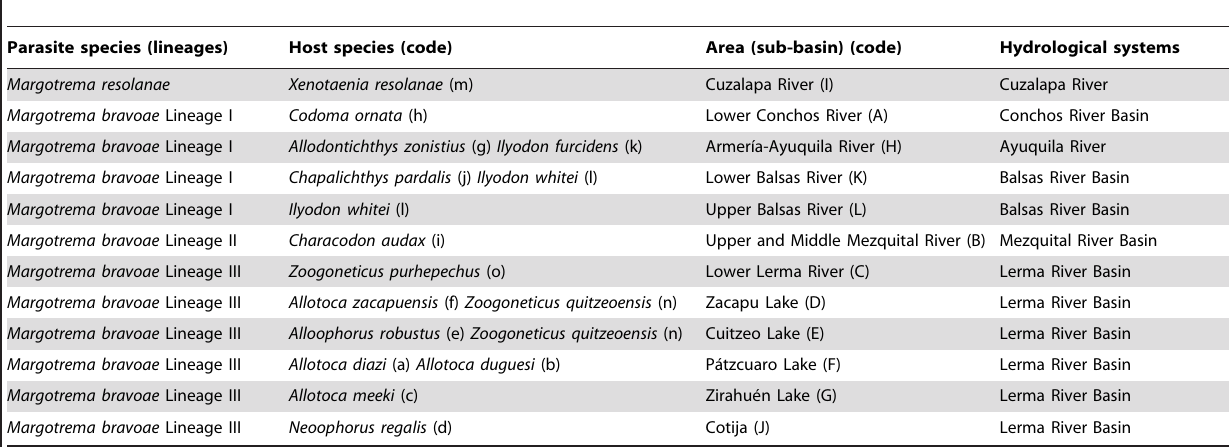
Table 1. Parasite-host-area associations of Margotrema species and lineages used in this study.